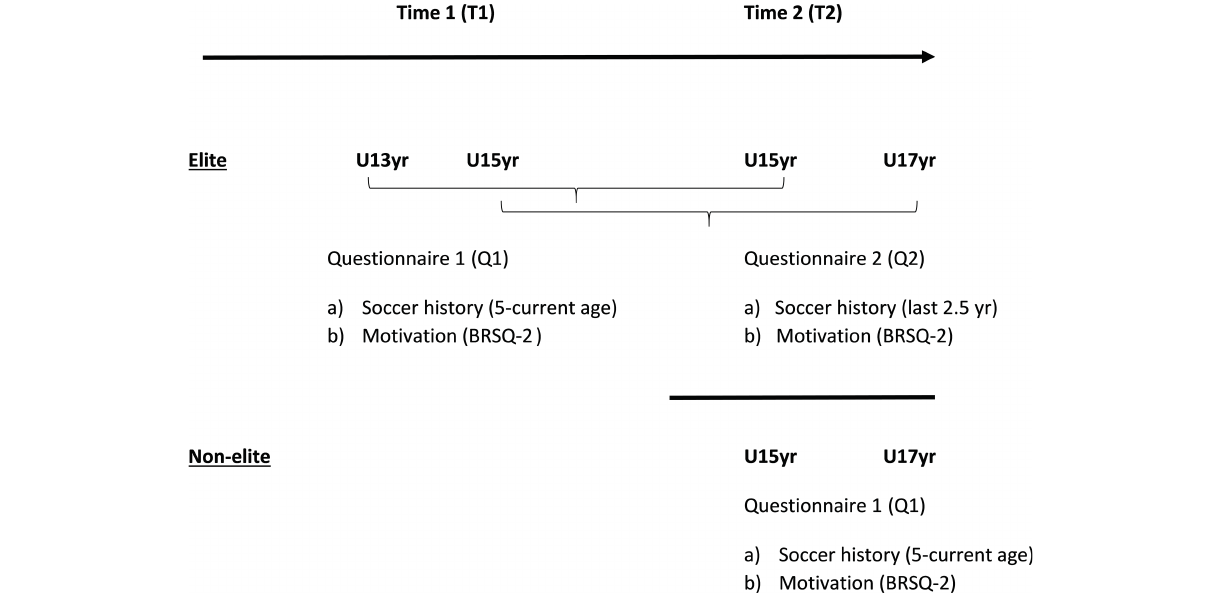
FIGURE 1 | Schematic to show the chronology of our procedures for collecting soccer activity estimates and self-determined motivation scores from the elite and non-elite players at time 1 and time